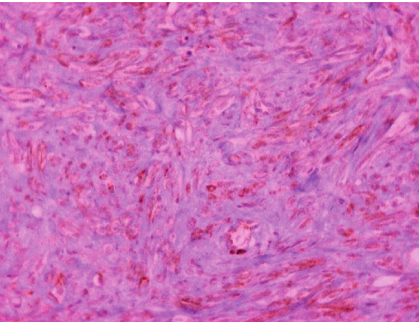
Figure 5: Spindle-shaped tumour cells were positive for CD34 (diaminobenzidine, × 400).